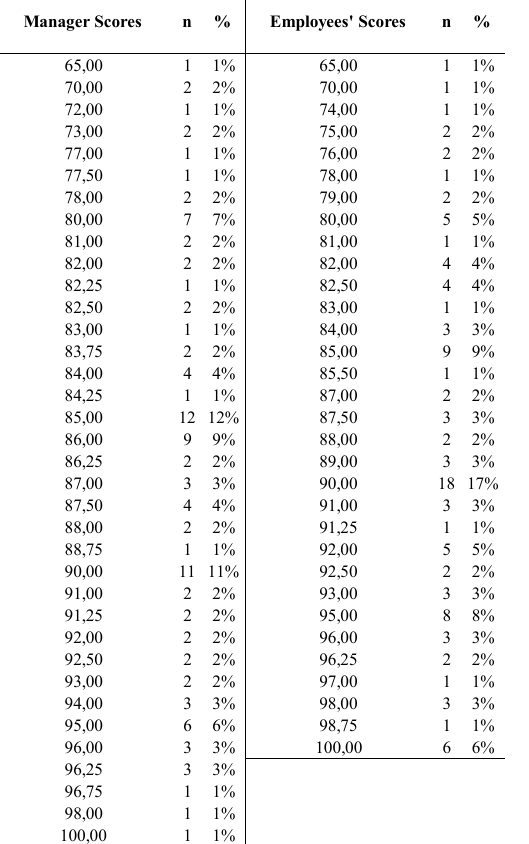
Table 3: Performance Scores Distribution